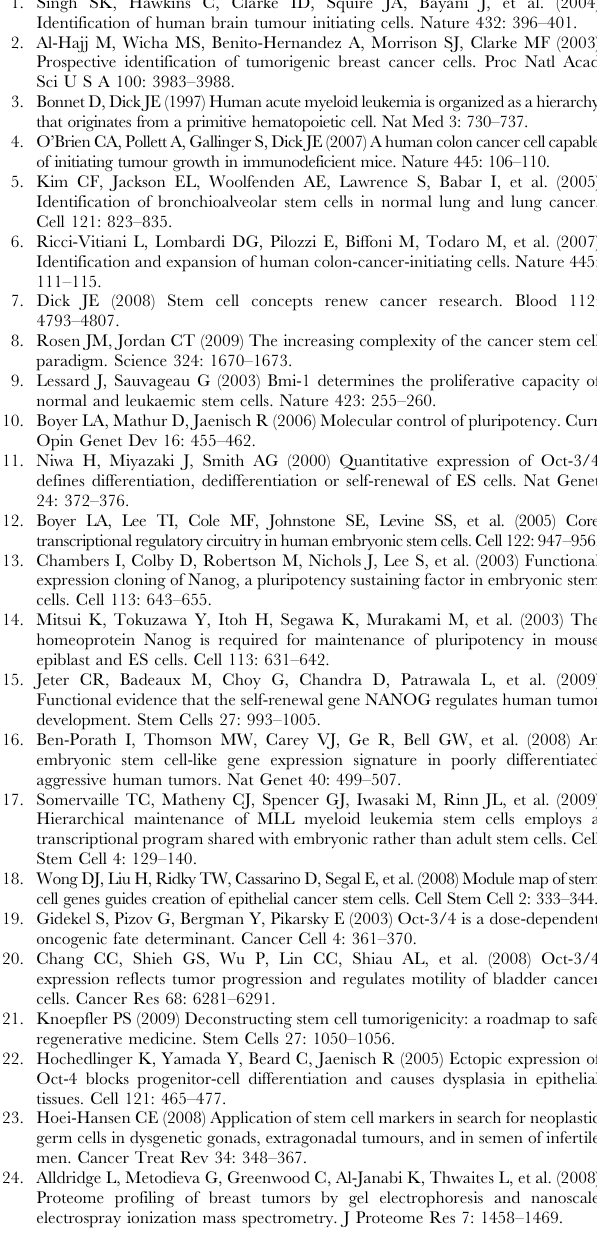
Table S1 Limiting dilution assay for teratoma formation from control and Oct4 knockdown t-hPSCs.